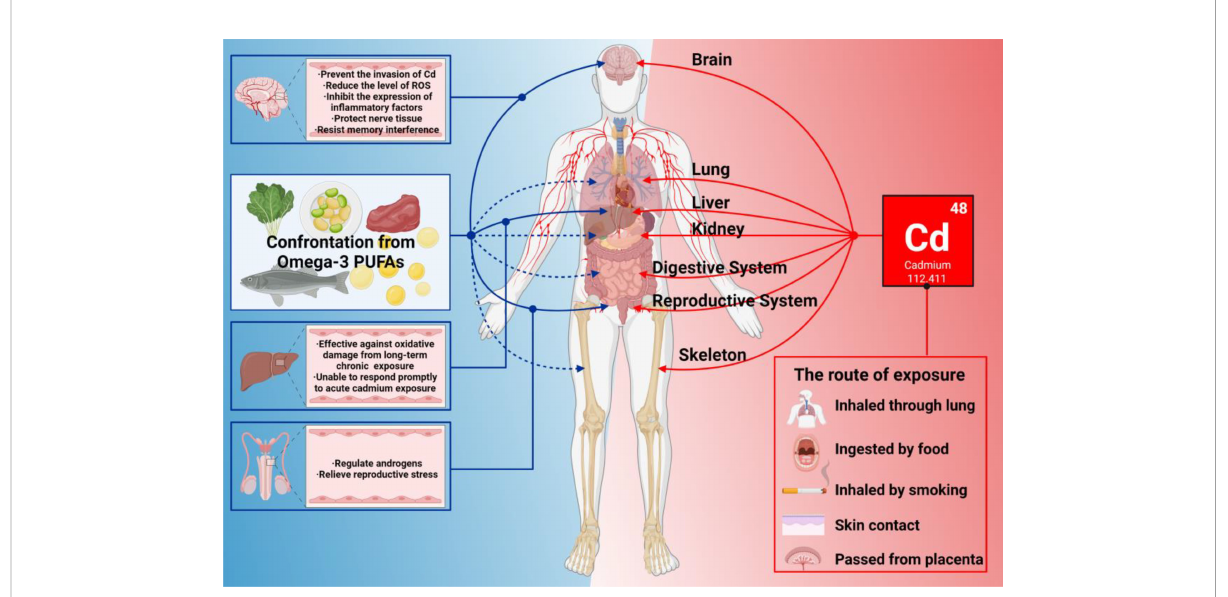
FIGURE 5 What n-3 PUFAs can do when Cd exposure harms bodies. In this fi gure, the red line represents the damage to various organs of the body caused by Cd exposure. The solid blue line represents the organ that has been studied so far with n-3 PUFAs that can resist damage from Cd exposure. The blue dashed line indicates that n-3 PUFAs are known to have a positive effect on the organ ’ s immune